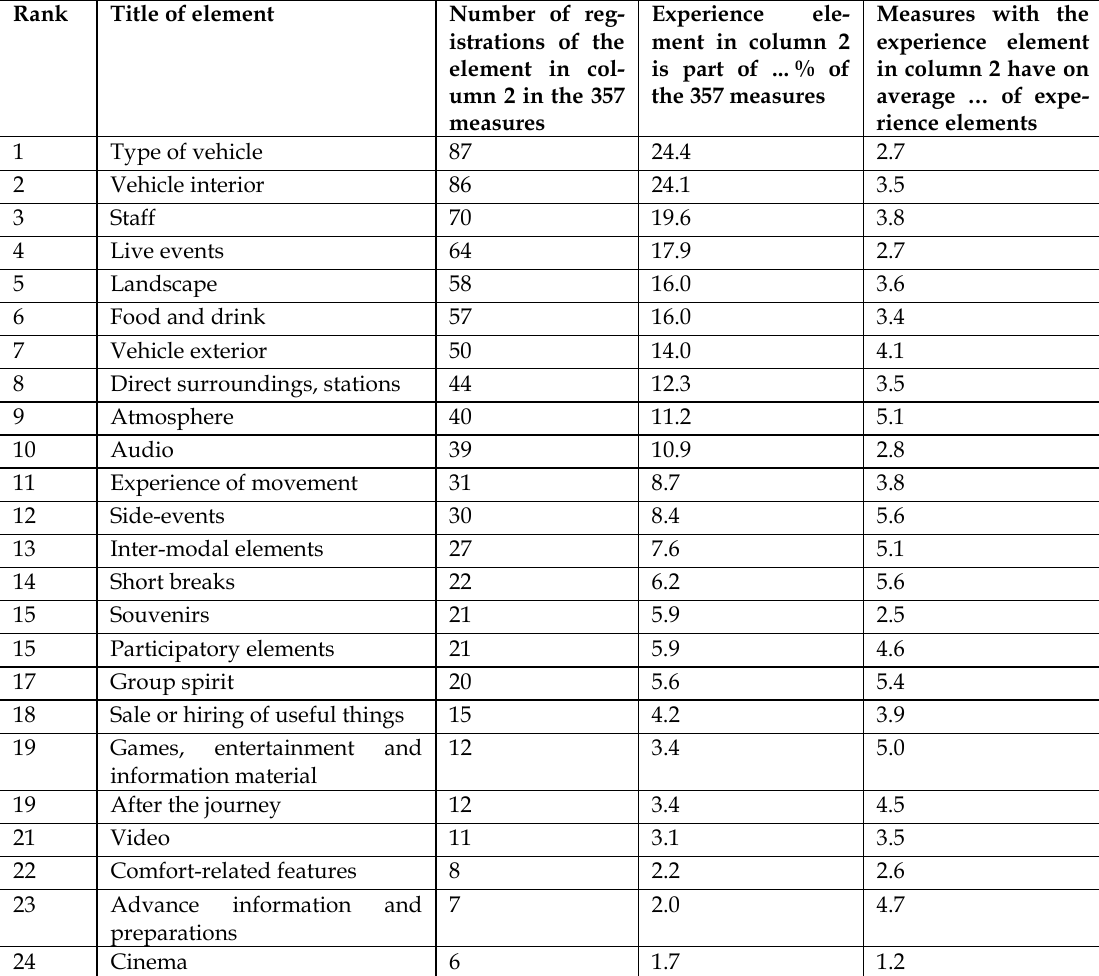
Table 3. Frequency and complexity of travel experience elements (author’s depiction)